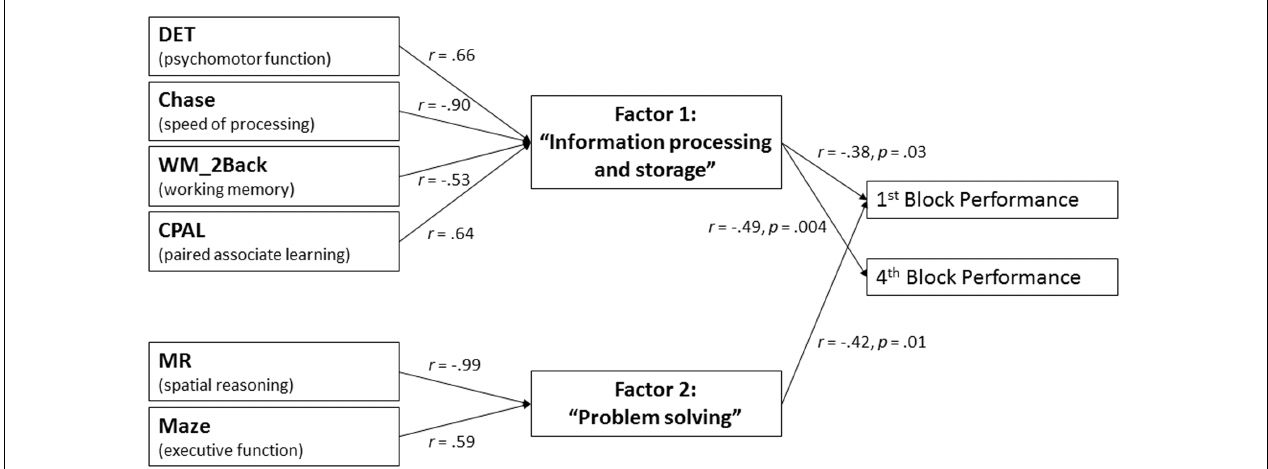
FIGURE 4 | Factor analysis. Two independent subsets of cognitive functions related to either basic processing and storage of sequence information (Factor 1) or complex problem solving (Factor 2) were extracted. Note that while the six cognitive functions on the left hand side of the graph are interrelated, the two factors are mathematically independent of each other. Factor loadings of cognitive functions on the factors are displayed on the left set of arrows. For interpretation of directionality, please refer to Table 1 . Significant correlations between factor scores and performance in the CSLT are displayed on the right set of